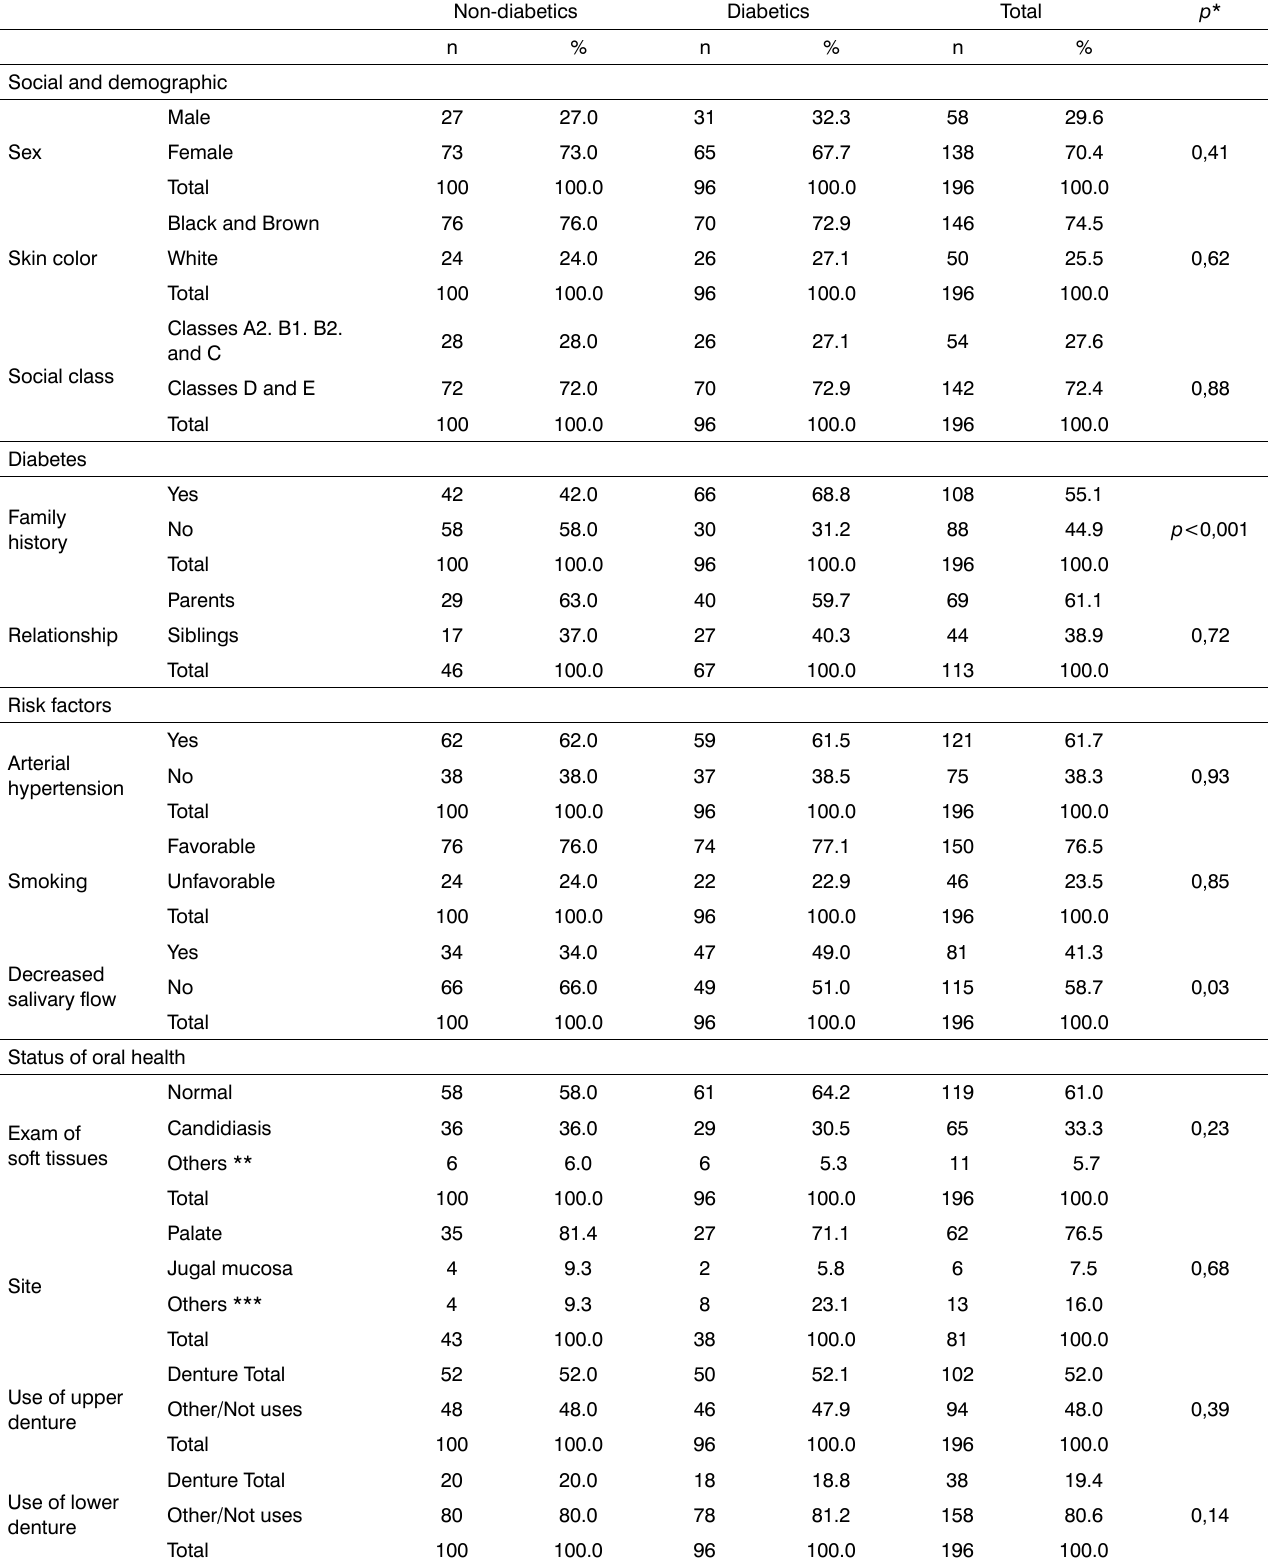
Table 2. Description of categorical variables in the study sample (2009). Non-diabetics Diabetics